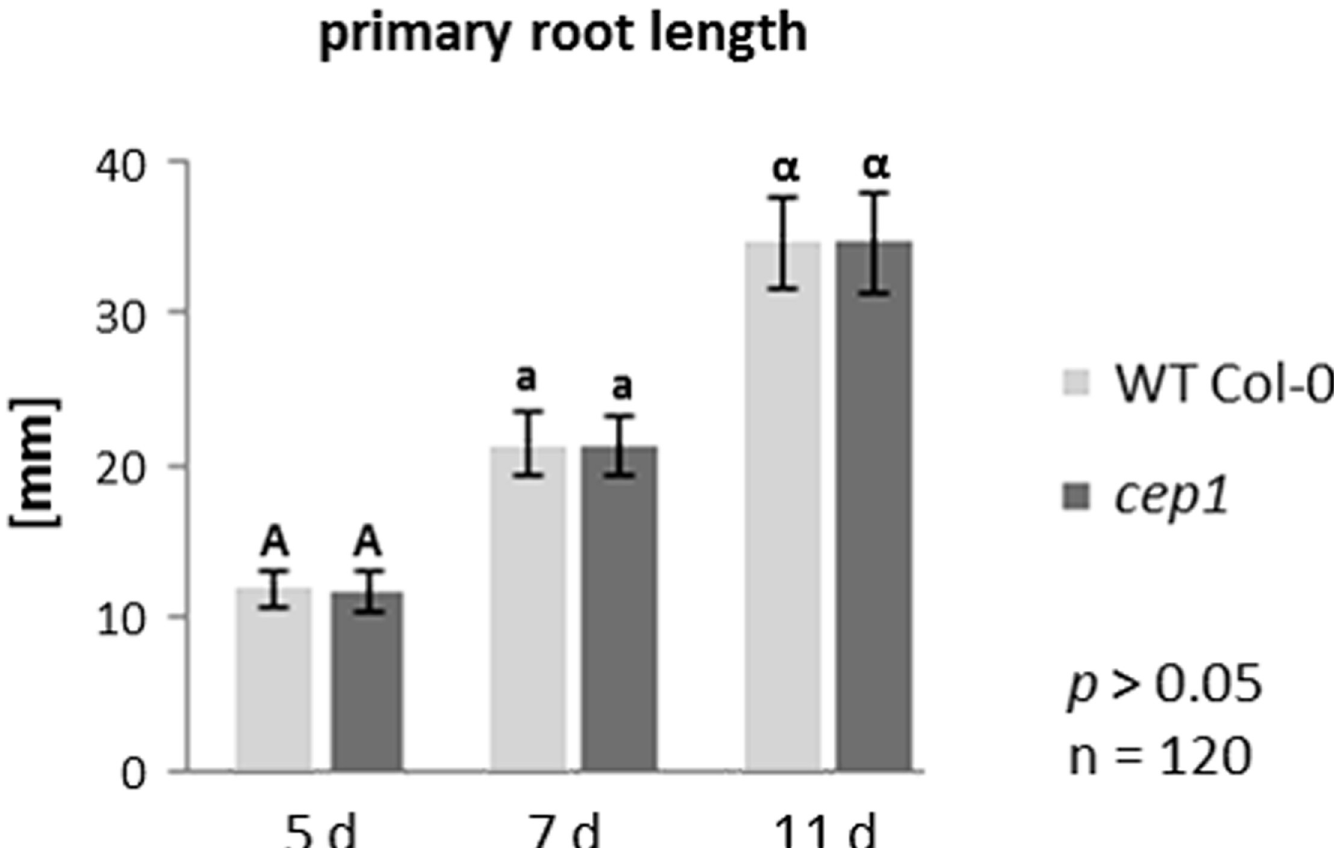
Fig 2. Single loss of function in cep1 mutant plants does not result in shortened primary root length. Comparison of primary root length in 5, 7 and 11 days old seedlings of homozygous cep1 ko mutant plants as compared to WT plants. Columns marked with similar letters indicate groups not statistically different according to the ANOVA-and Duncan test ( p > 0.05). (B) Primary root length expressed as percentage of WT plants. Data represent the respective means of two independent experiments (biological replica) each comprising 120 plants per